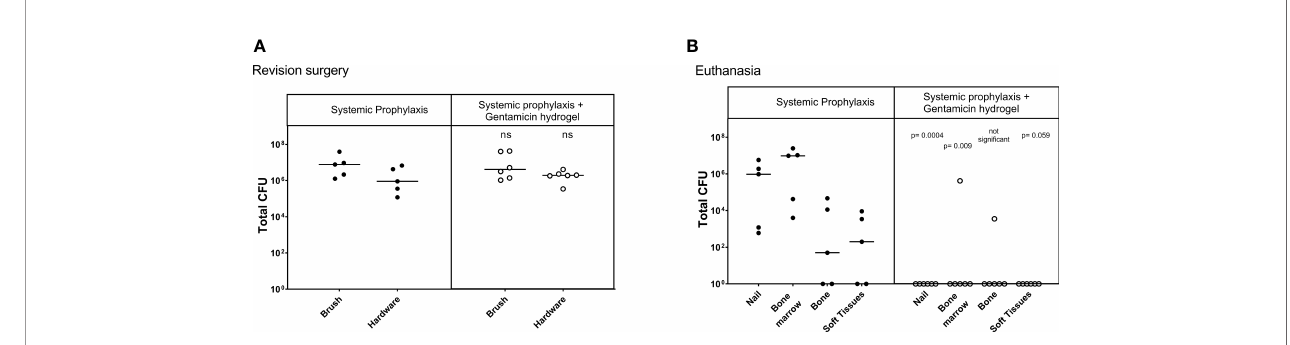
FIGURE 2 | Bacteriology at revision (Left) and euthanasia (Right) in the one-stage treatment model. CFU counts were obtained from individually collected tissue samples during revision, where biopsies and hardware were removed, and at euthanasia, where the entire limb was dissected. Statistical comparisons are per location for each group. Lines represent median values, statistical comparison by two-sided T-test of Log